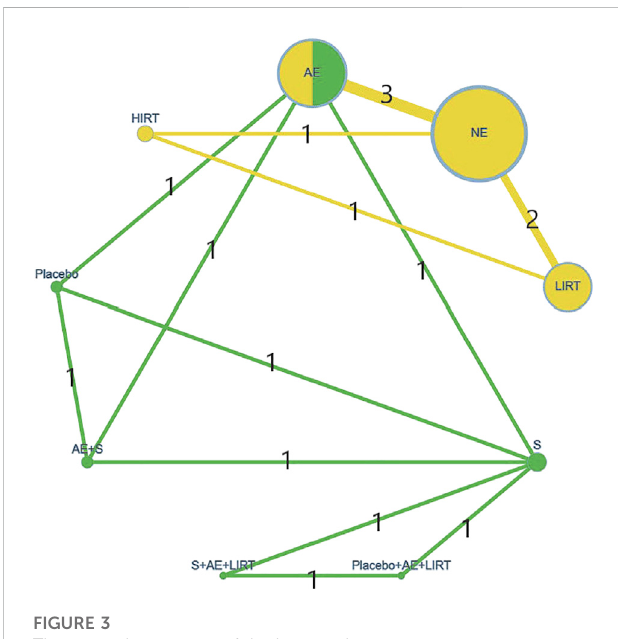
FIGURE 3 The network geometry of the interventions.